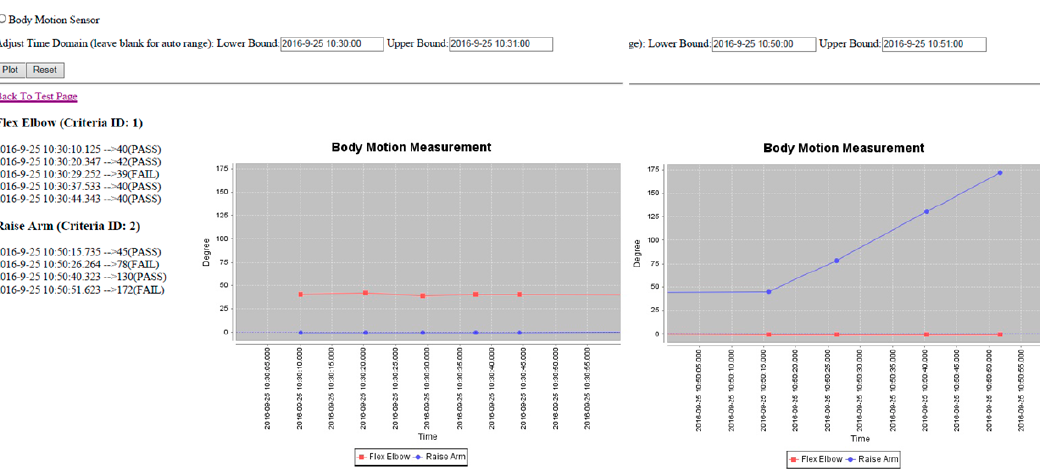
Figure 10. Web-based interface for UHC measurement to monitor flexion exercises “flex the elbow” and “raise the arm” in different periods.